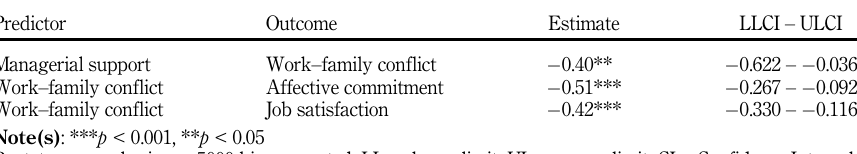
Table 3. Direct effects